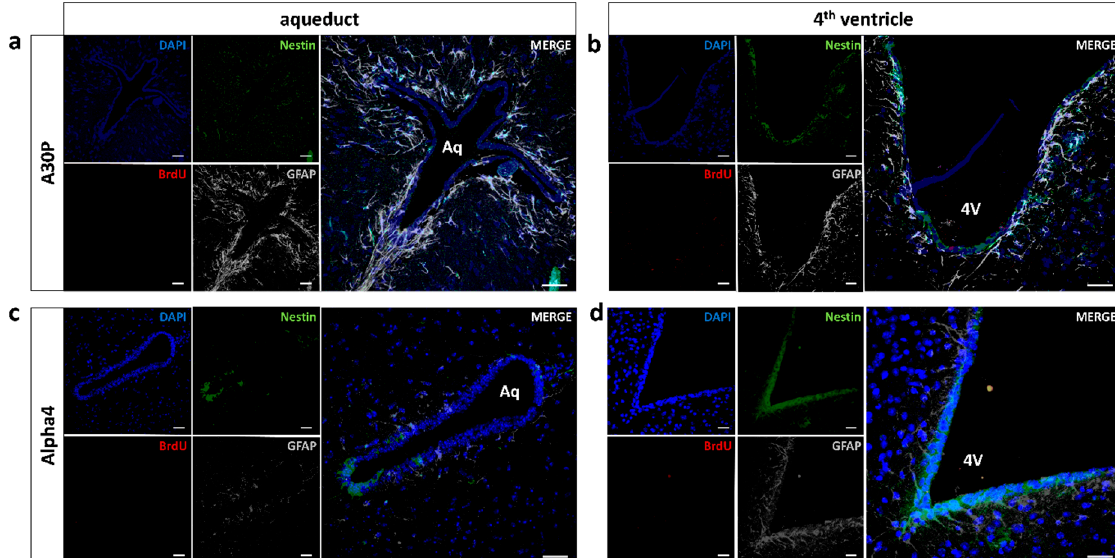
Figure 3. Proliferative activity in mid/hindbrain PVRs. Representative fluorescence image of mid/hindbrain periventricular regions. Daily BrdU injections over 3 days were performed prior to perfusion to label proliferating cells (red). To differentiate between the various cell types within a putative neurogenic cascade, quadruple immunostainings with DAPI/BrdU/nestin/GFAP were performed. Representative images of ( a ) the aqueduct and ( b ) the 4th ventricle in an h[A30P]m α -synuclein mutant mouse without evidence of a single BrdU + cell (red). Further immunostainings were made for nestin (green) and GFAP (grey); cell nuclei were counterstained with DAPI (blue). Identical immunostainings were performed in ( c ) the aqueduct and ( d ) the 4th ventricle of L’S α 4* nAChR mice. Scale bar = 50 μ m. Abbreviations: Aq—aqueduct; 4V—4th ventricle; WT—wild-type; m[A30P]h—mutant human A30P α -synuclein mutant mice; BrdU—bromodeoxyuridine; GFAP—glial fibrillary acidic protein. All data are presented as mean ± standard error of the mean (SEM); n = 3 each ( a ; b ); n = 4 ( c ; d )